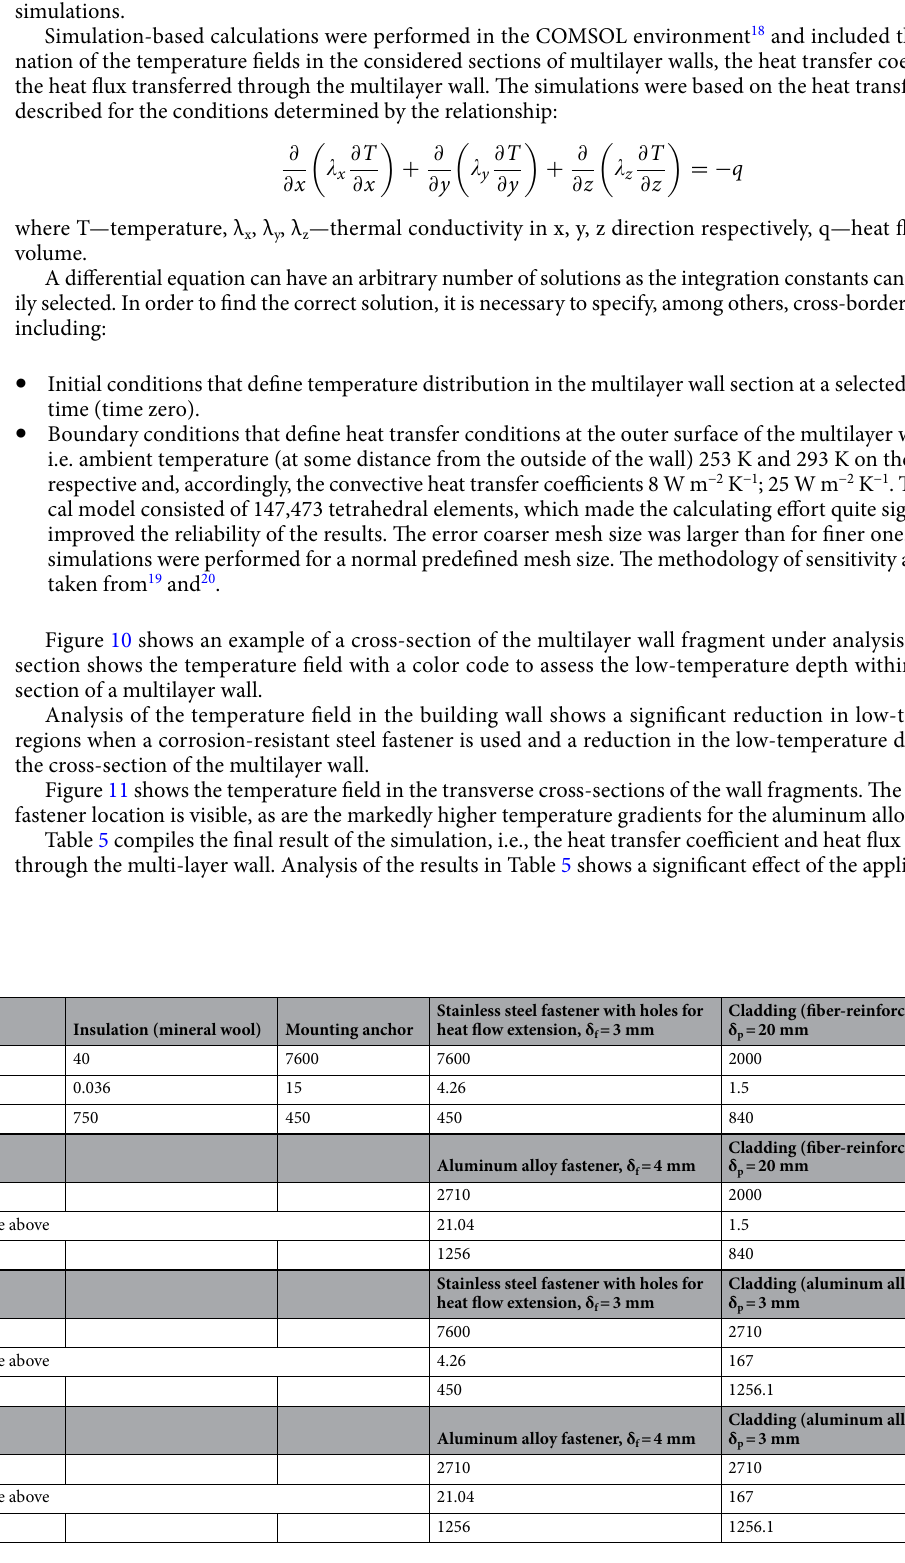
Table 4 compiles the data of the materials used in the multi-layer wall elements included in the numerical simulations. nation of the temperature fields in the considered sections of multilayer walls, the heat transfer coefficient and the heat flux transferred through the multilayer wall. The simulations were based on the heat transfer equation described for the conditions determined by the relationship: